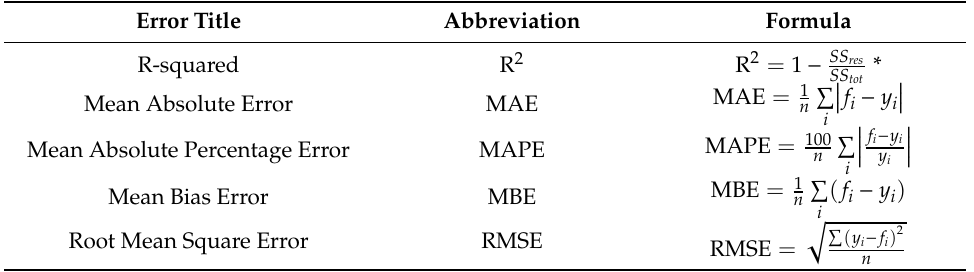
Table 4. Used mathematical criteria to evaluate forecast errors.